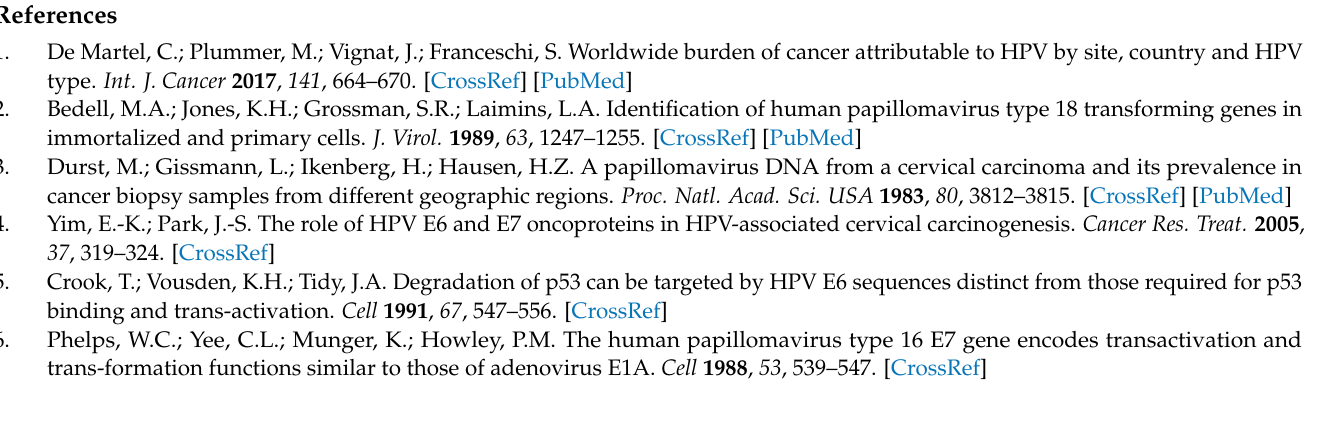
Figure S2: Summary of Geneset enrichment analysis (GSEA) following RNA sequencing. Hallmark pathways were tested for enrichment (up regulated: bars to the right) or disenrichment (down regulated: bars to the left) in these two conditions. significance of the change after adjusting for multiple hypothesis testing (Benjamini-Hochberg method) is indicated by the colors indicated in the key. Figure S3: Coomassie staining of the recombinant USP46 shows that it is not stoichiometrically associated with any insect protein. Dilutions of BSA were used for accurate quantitation of the recombinant USP46. Figure S4: Original western blots. Tables S1: Metrics indicating quality of RNA sequencing. Table S2: Metrics summarizing the alignment of RNA sequencing